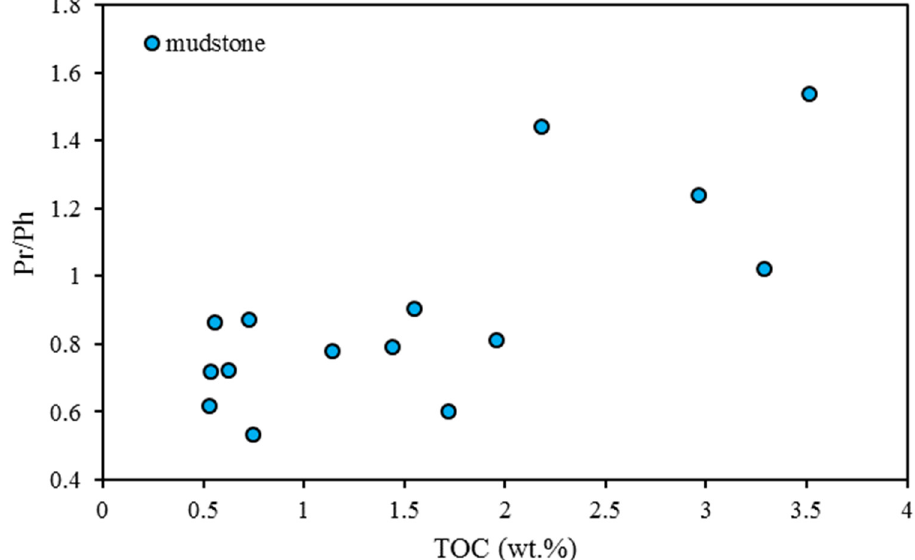
Figure 17. Relationship between Pr/Ph and TOC for coal ‐ measure source